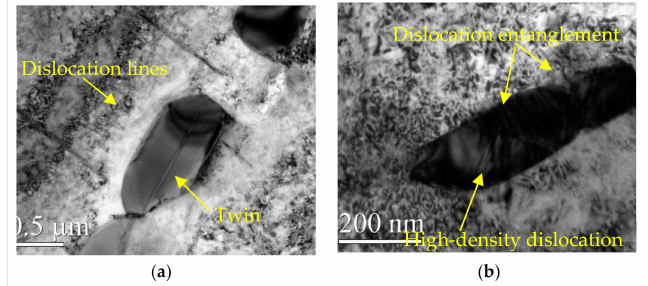
Figure 8. The change of the δ phase shocked by LSP at di ff erent temperatures: ( a ) 25 ◦ C, ( b ) 200 ◦ C.